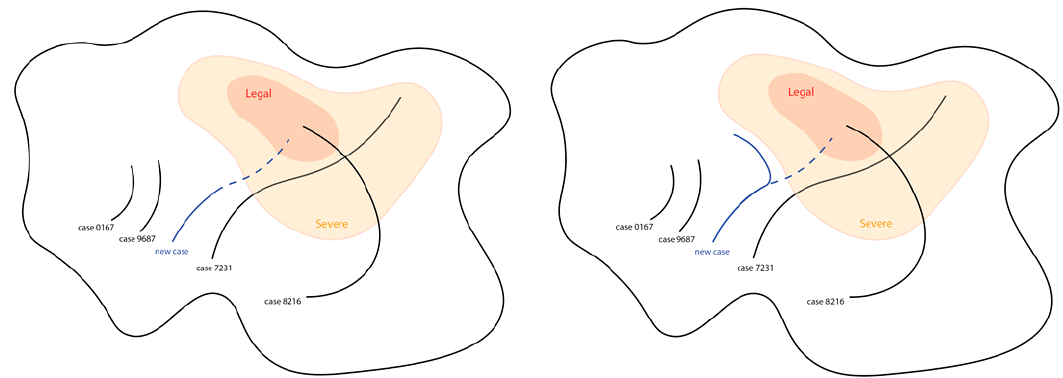
Figure 4. Concept of latent space in SWIM 1.0.